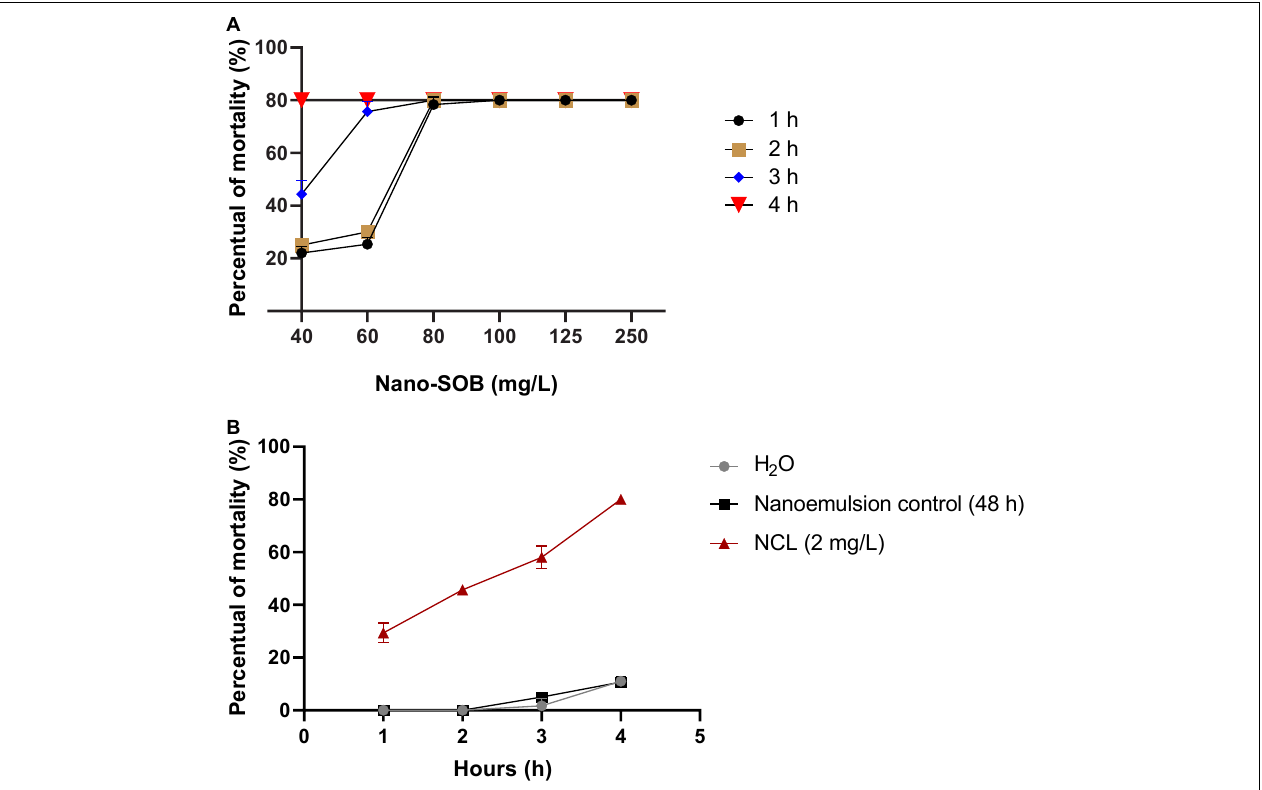
FIGURE 4 | Nano-SOB activity against Schistosoma mansoni cercariae for 4 h (A,B) . The test was carried out in triplicate on different days using a range of 80 cercariae per well during the testing of the samples. These data are expressed as the mean ± SD. Using the two-way ANOVA test, the value of R 2 is determined as 0.8660, with a P- value of <